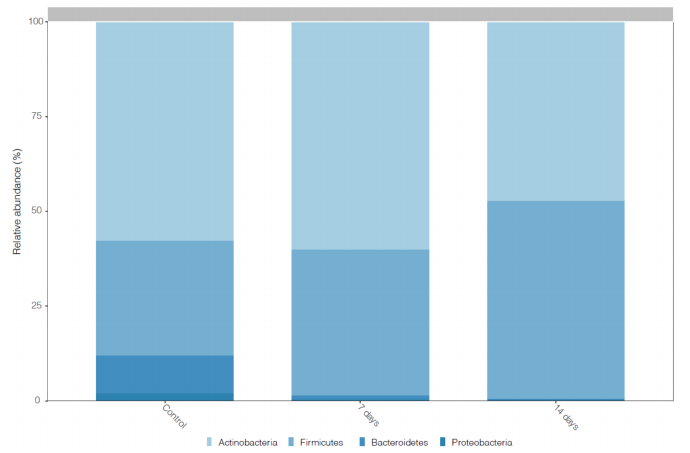
Figure 3. Histogram of the community composition of gut microbiota at the phylum level. Control = control period, 7 days: 7 days of treatment with L. helveticus R0052 and B. longum R0175 and 14 days: 14 days of treatment with L. helveticus R0052 and B. longum